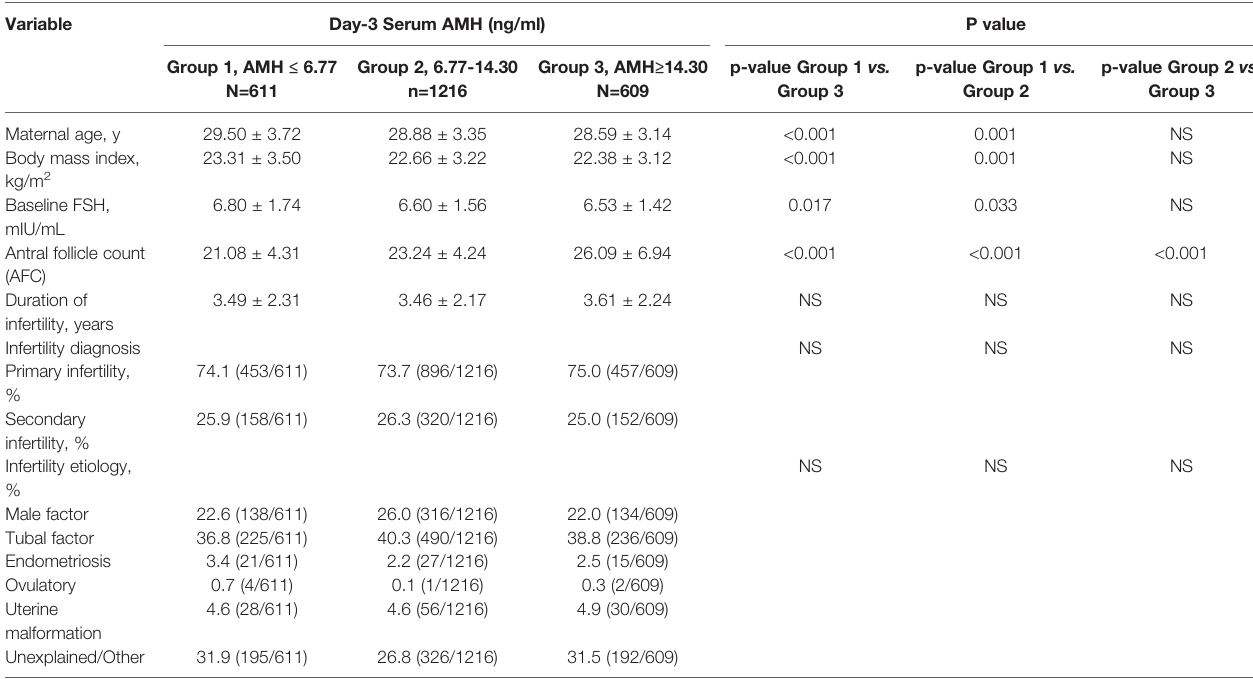
TABLE 1 | Baseline